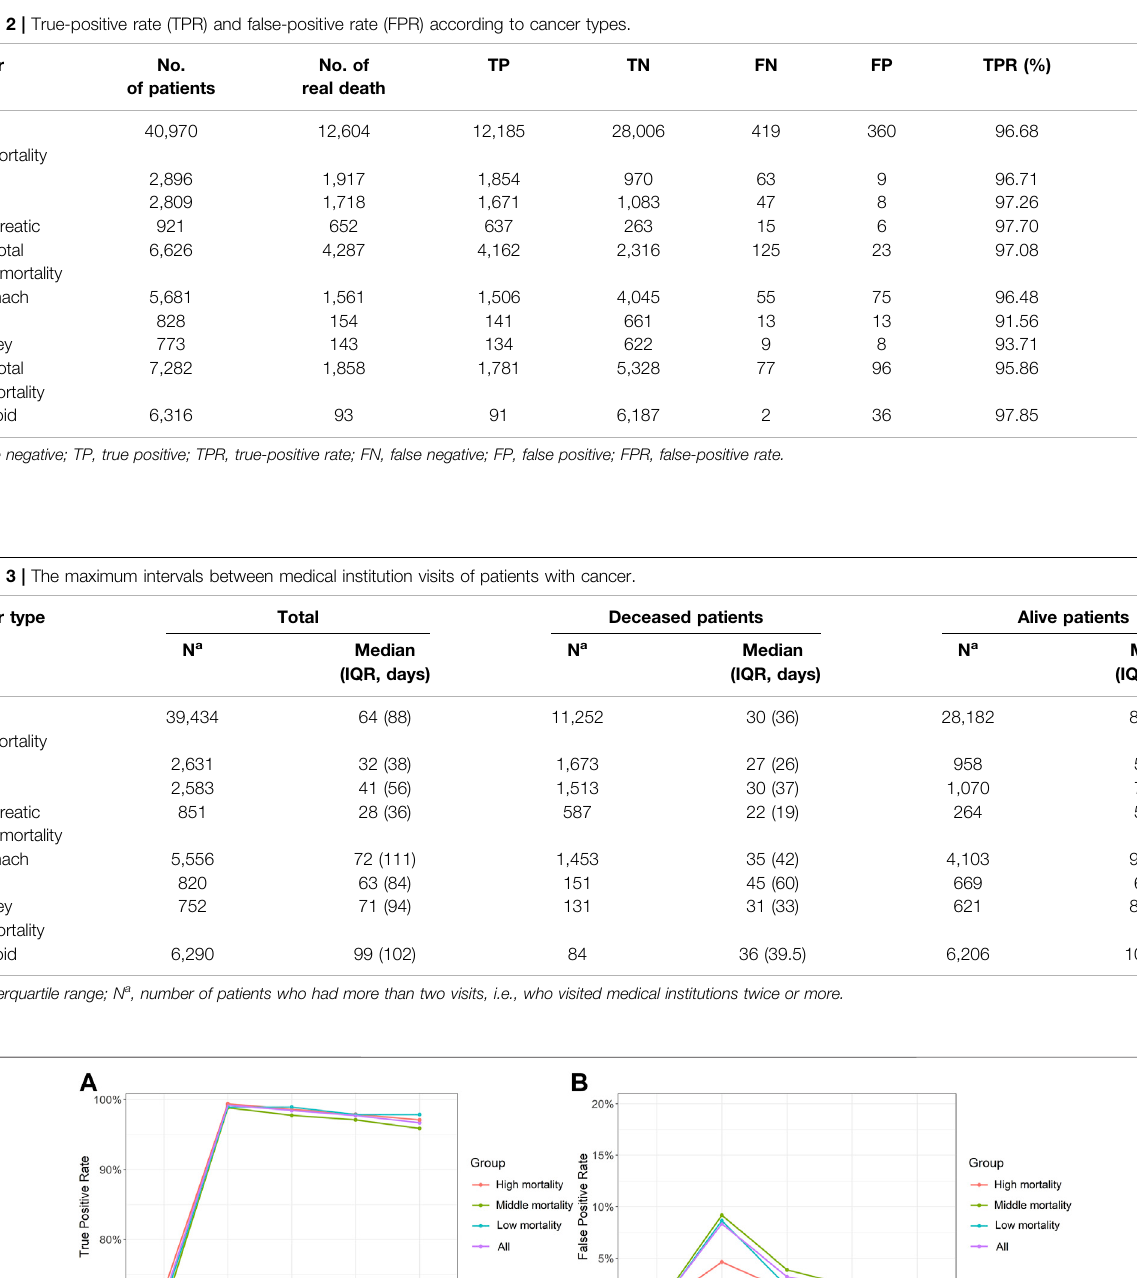
TABLE 2 | True-positive rate (TPR) and false-positive rate (FPR) according to cancer types. Cancer type